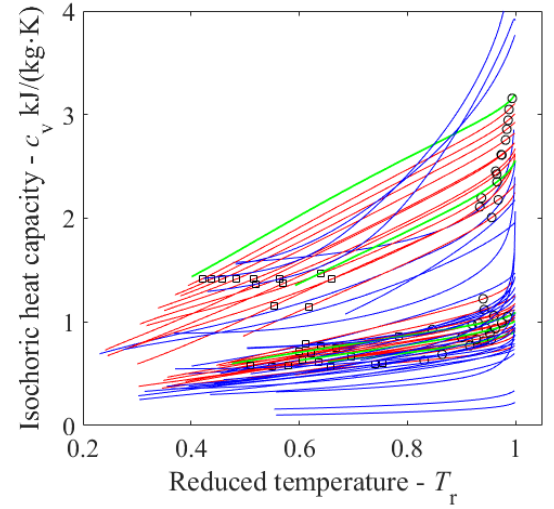
Figure 3. Isochoric specific heat capacity (kJ/kg · K) curves of various working fluids in saturated vapor conditions; blue, red, and green curves represent wet, isentropic, and dry materials, respectively. Squares and circles represent points N (lower temperature) and M (higher temperature).